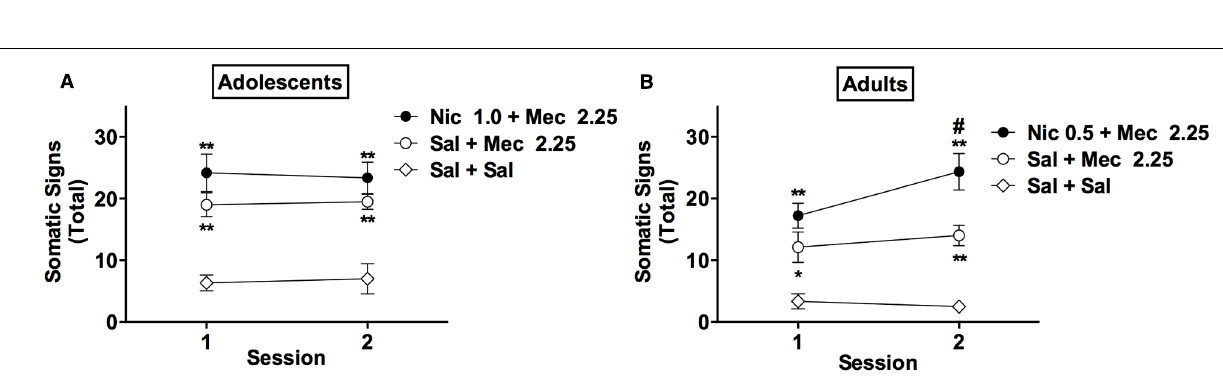
FIGURE 2 | Nicotine levels in adolescents and adults following acute nicotine. Mean ( (cid:6) SD) serum (A) and brain (B) nicotine concentrations and brain:serum nicotine concentration ratios (C) in adult and adolescent rats in Experiment 2. **Significantly different from adults receiving 0.5 mg/kg nicotine, p < 0.01.